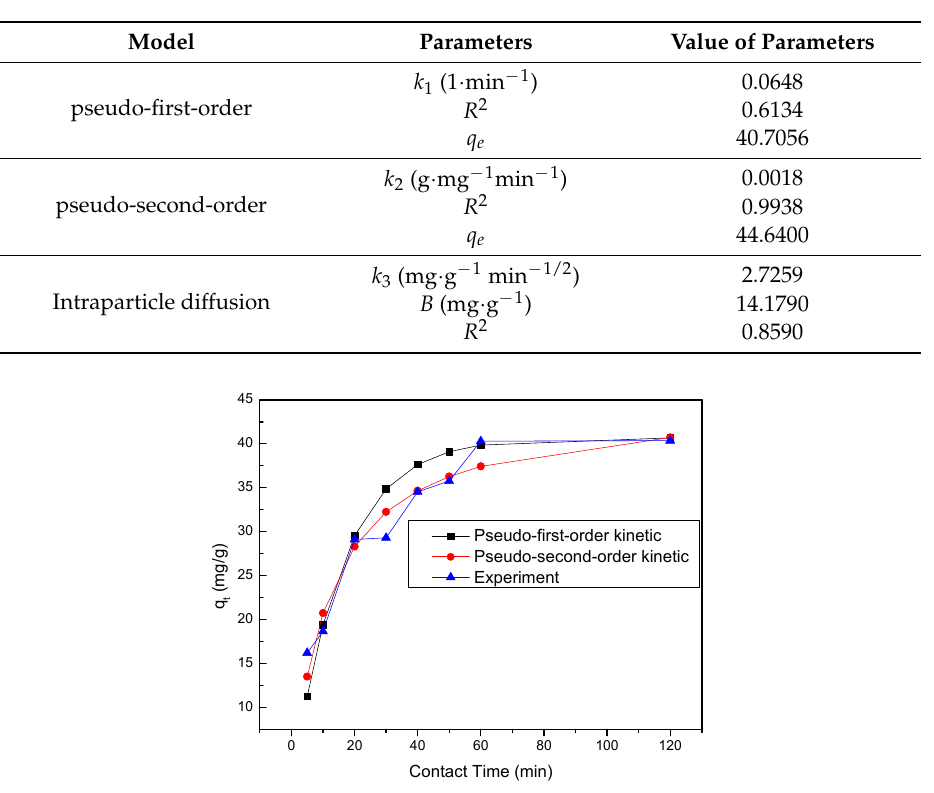
Figure 11. Time dependent study of Se(IV) removal by nZVI/rGO composites (initial pH = 8.0; nZVI/rGO dosage = 30 mg; T = 25 °C; C = 30 mg/L).